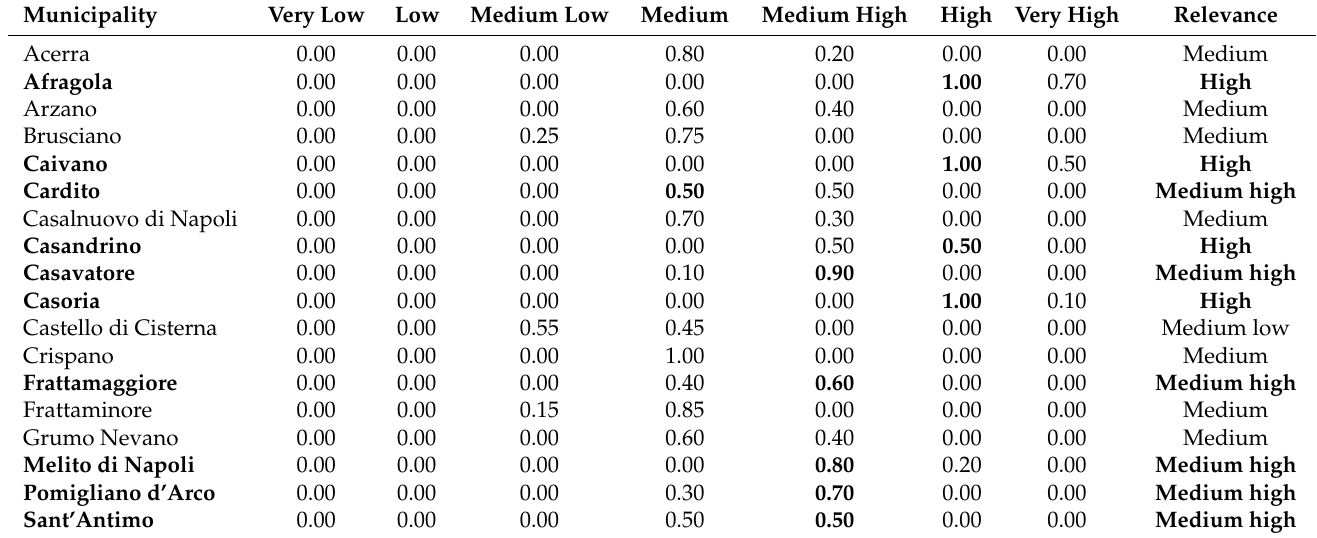
Table 5. Relevance of unpleasant emotional categories in the year 2021.